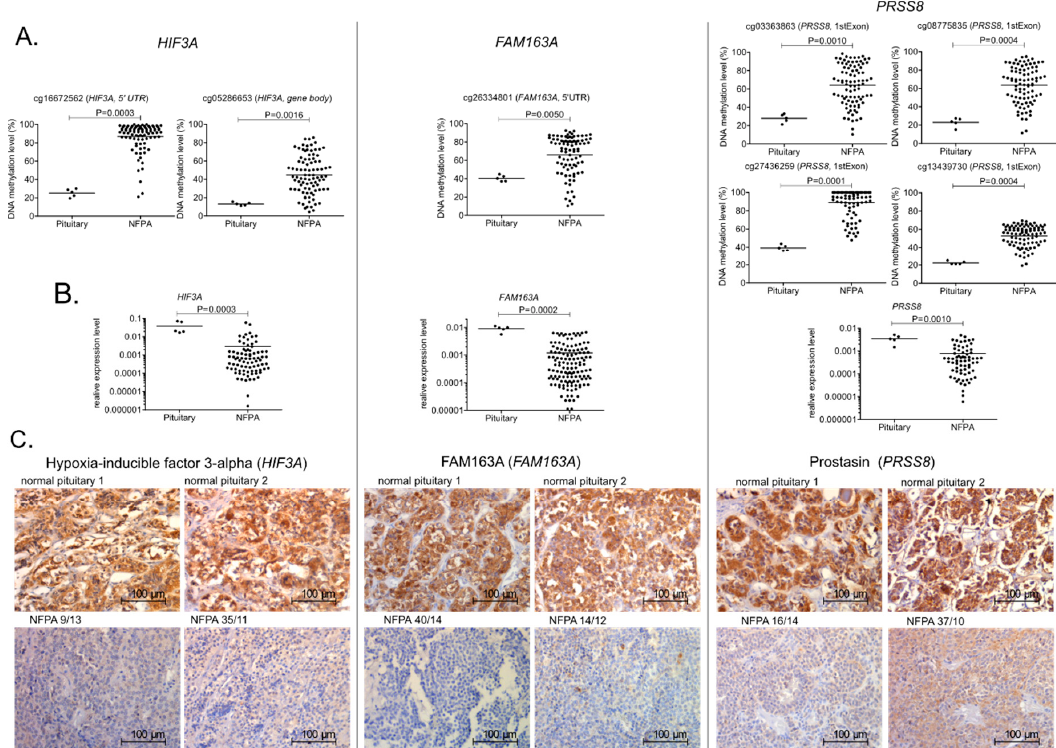
Figure 4. Difference in DNA methylation at regulatory regions, and expression levels of HIF3A , FAM163A, and PRSS8 in gonadotroph NFPA samples and normal pituitary. ( A ) Pyrosequencing analysis of CpG sites . Each dot represents the methylation level in a particular sample. Mean values are shown as horizontal lines. ( B ) Relative expression levels of HIF3A , FAM163A, and PRSS8 in normal pituitary and NFPAs. Each dot represents the expression level in the sample. Mean values are shown as horizontal lines. ( C ) Examples of immunohistochemical staining of normal pituitary and NFPAs with antibodies against HIF3A, FAM163A, and prostasin (PRSS8). Magnification, ×400.